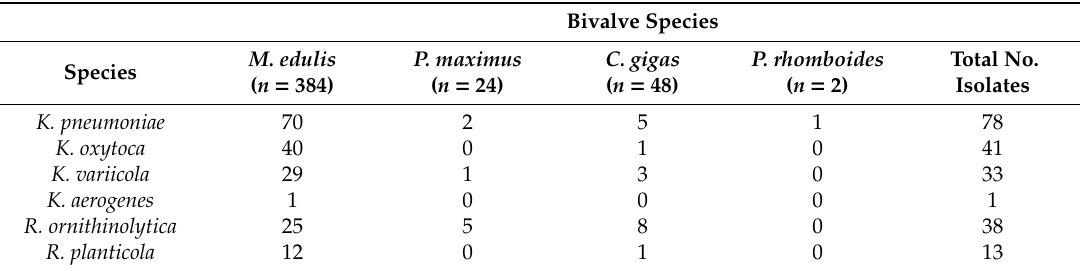
Table 1. Klebsiella spp. and Raoultella spp. isolated from di ff erent bivalve mollusc species, n in